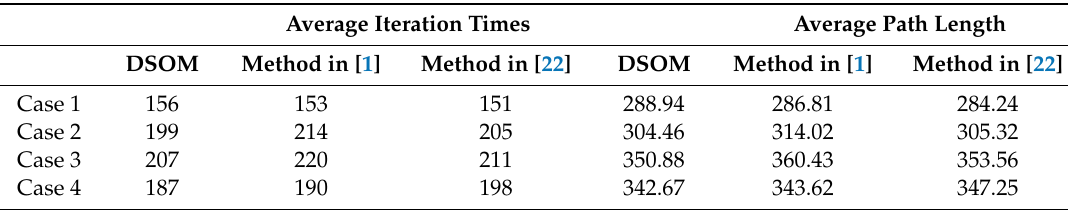
Table 1. Comparisons of the average iteration times and path